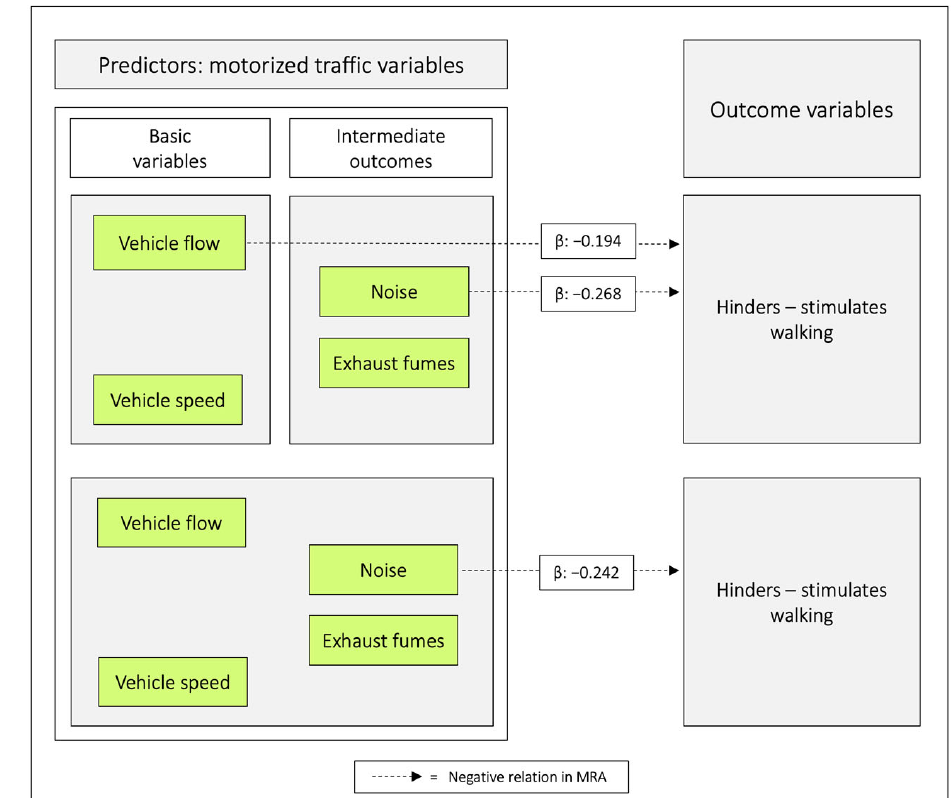
Figure 7. Regression coefficients between combinations of the predictor variables in relation to hinders–stimulates walking. Note: β = unstandardized beta. The figure is based on Table 7.